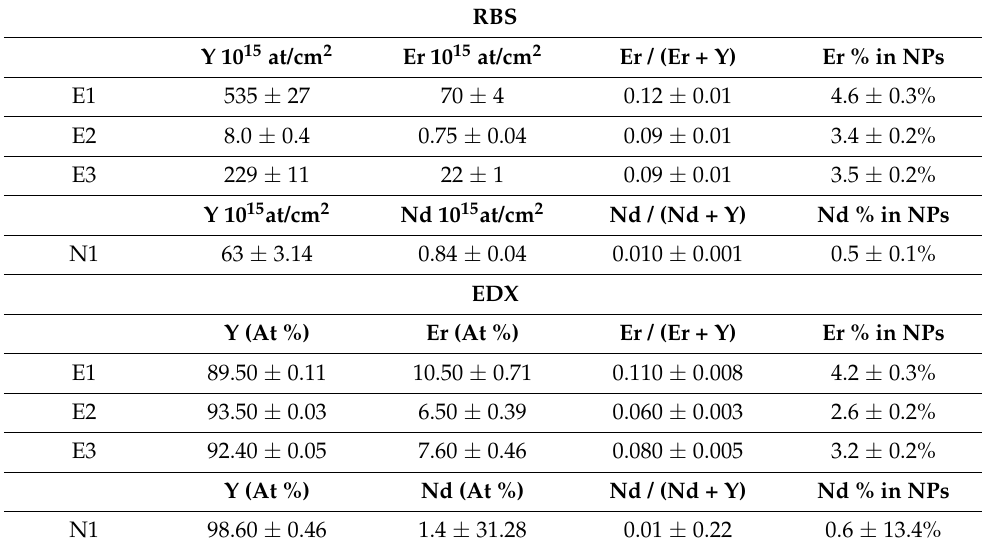
Table 2. Elemental concentrations as determined by RBS analysis and EDX